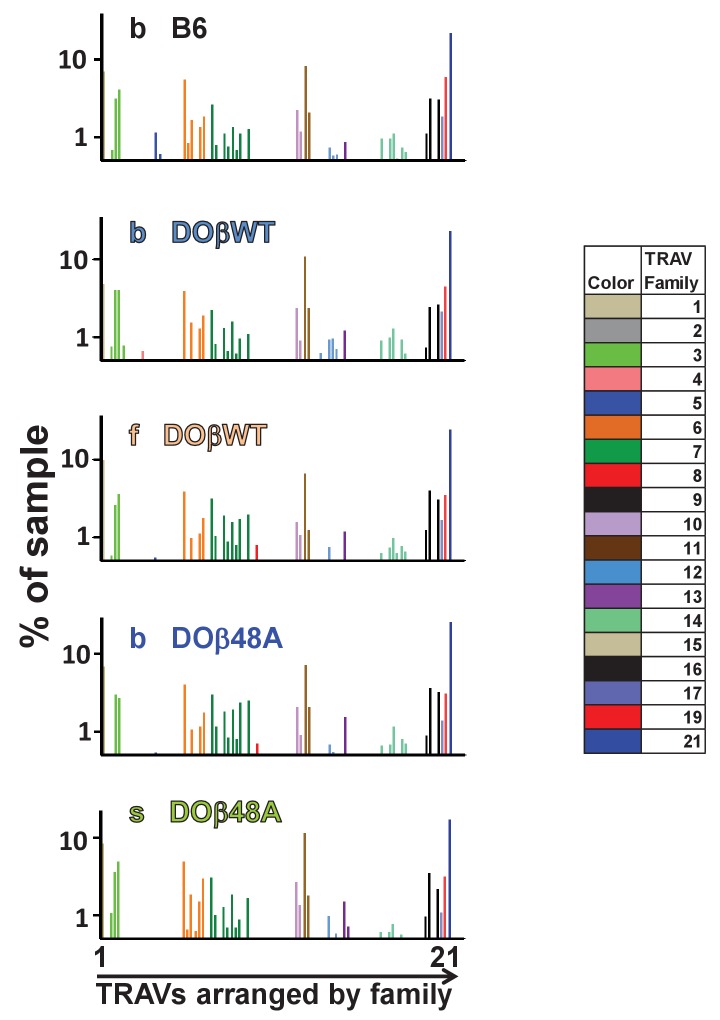
Different TRAVs are detected at different frequencies in preselection thymocytes.Preselection DP thymocytes were obtained from individual mice expressing the indicated MHCII alleles and TCRβs. Shown are the %s with which individual TRAVs were detected. Subfamily members of each family are color coded as shown. Note, the TRAVs are ordered by family and not by their position in the TCRα locus.